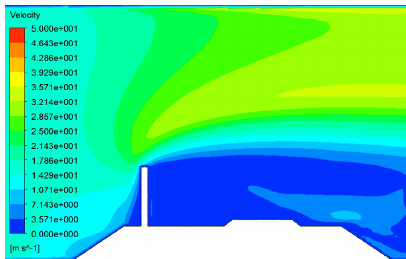
Fig. 17. Wind speed contour of computational domain with single wind-break wall under wind-sand flow